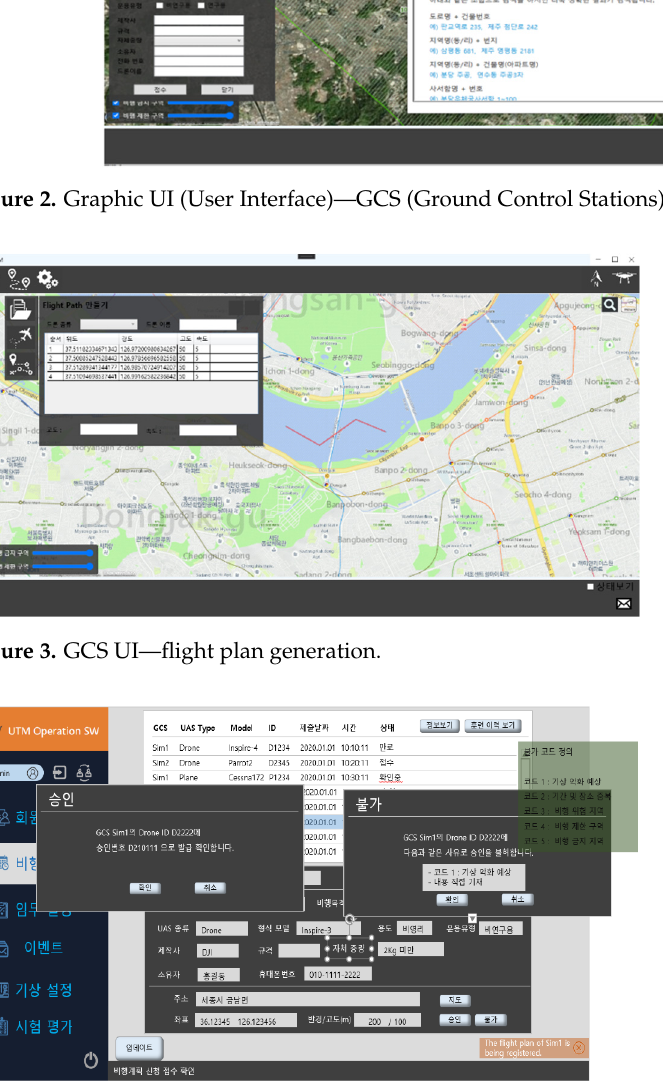
Figure 5. UOS UI—simulation control window. Figure 6. UTM (UAS Traffic Management) UI—UAS (Unmanned Aircraft Systems) control window. eUTM simulator is composed of a UTM simulator and two GCS simulators. The UTM simulator comprises Airspace Management Module, Geo Information Module, Conflic- tion Prediction Module, Simulation DB Module, UTM Module, and UOS. The relevant functions are elaborated in Figure 1. Figure 2 shows a GCS UI (User Interface), requesting a flight plan. UI is designed based on the rule dictated by KRPASA [20], where information of airspace notice and